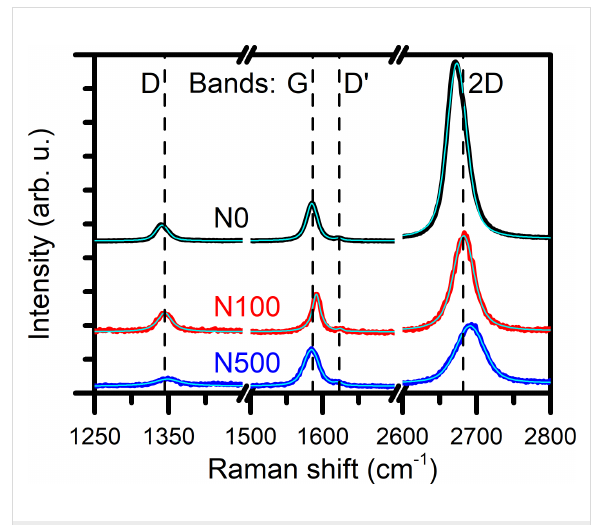
Figure 2: Representative Raman spectra of graphene on NWs with dif- ferent variations in height normalized to the G band intensity. Light blue lines are fitted